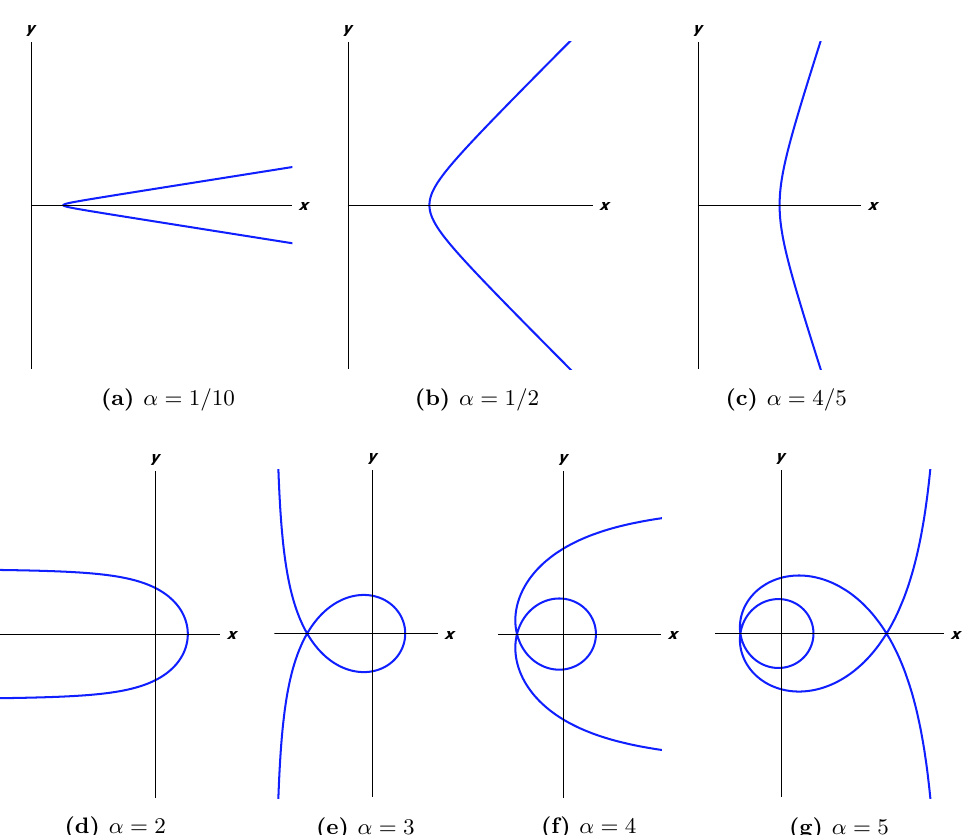
Figure 1. Some examples of the geodesics in the conical geometry. The axes are oriented so that the perihelion is on the positive side of the x -axis ( ϕ = 0 ). From the first three figures one sees ∗ that for 0 < α < 1 , the dynamics is somewhat similar to that in the Kepler-Coulomb problem in the case of repulsive potential. For the shown integer values of α the t = −∞ and t = + ∞ straight line asymptotes coincide with a vertical line for odd values of α , and are parallel horizontal lines for even values of α